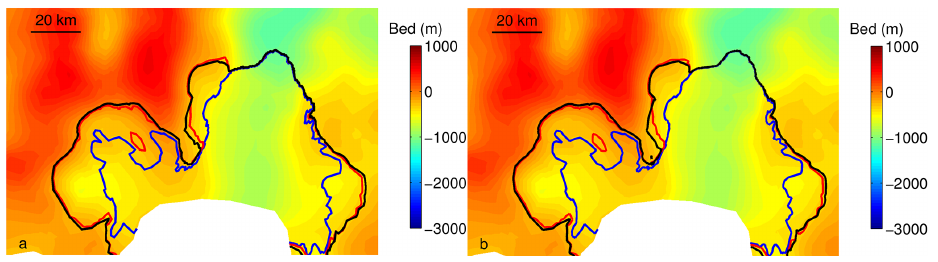
Figure 6. Grounding line position at the beginning of the experiments (blue line), and at the end of the melting experiments in the case of β = 1 (red line) and β = 2 (black line) overlain on the bedrock elevation. The mesh resolution is 500m (a) and 250m (b) in the grounding line